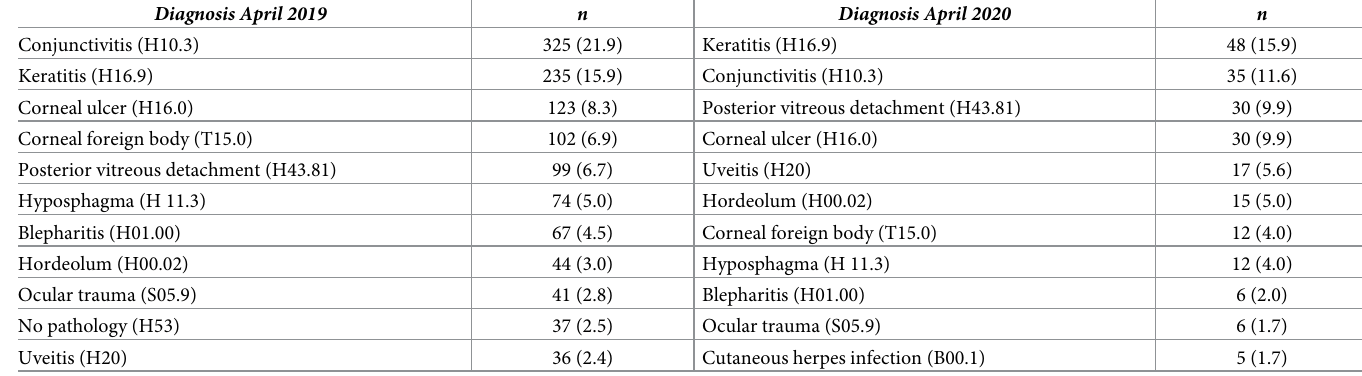
Table 3. Leading diagnoses and their International Statistical Classification of Diseases and Related Health Problems, Tenth Revision (ICD-10) codes in the repre- sentative month of the COVID-19 pandemic outbreak (April 2020) compared with the same month of the year before. Diagnosis April 2019 n Diagnosis April 2020 n Conjunctivitis (H10.3) 325 (21.9) Keratitis (H16.9) Corneal ulcer (H16.0)